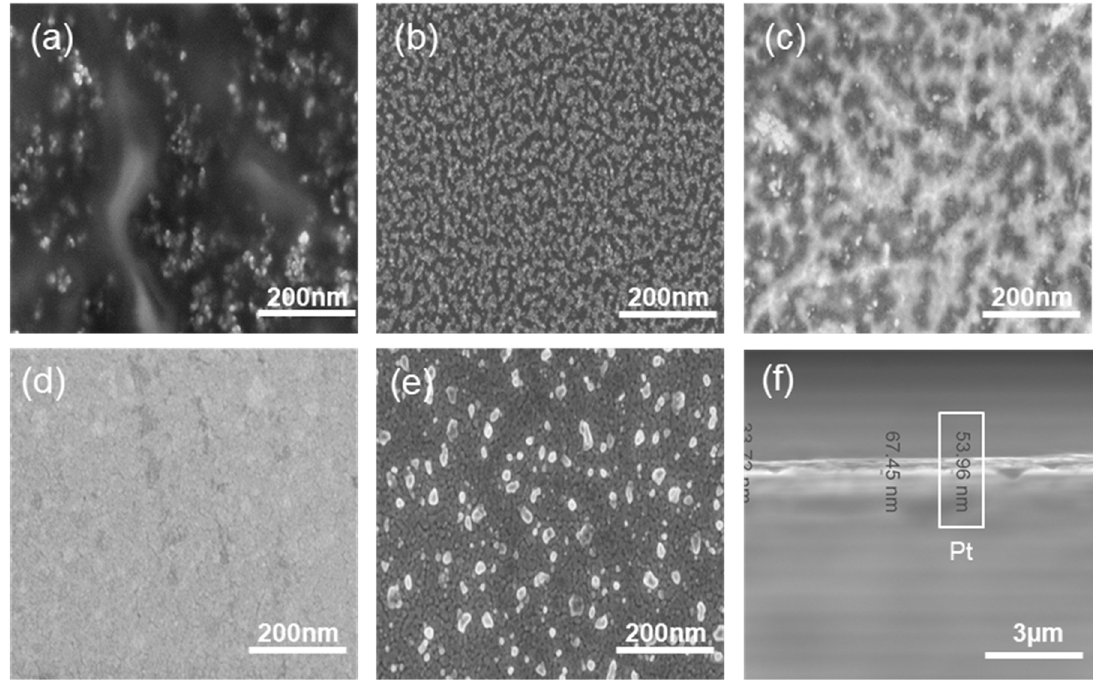
Figure 3. FESEM of graphene layers on top of different Pt thicknesses ( a ) 5; ( b ) 10; ( c ) 30; ( d ) 40; ( e ) 50 nm; ( f ) cross section of 50 nm PtO.